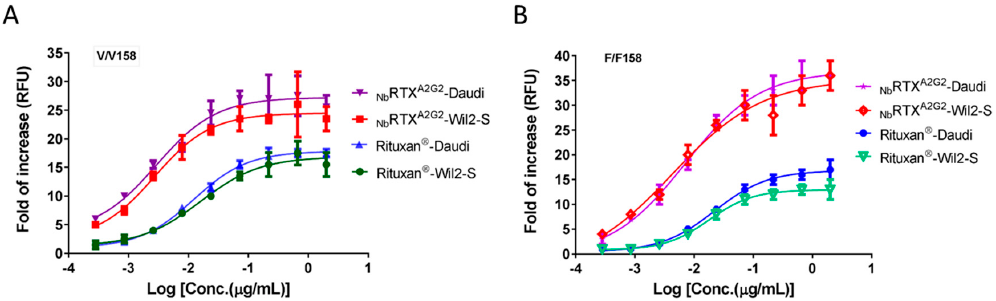
Figure 5. Antibody-dependent-cell-mediated cytotoxicity (ADCC) activity of Rituxan ® and Nb RTX A2G2 with ( A ) V/V 158 Fc γ RIIIa (high affinity) and ( B ) F/F 158 Fc γ RIIIa (low affinity) variant effector cells (engineered Jurkat cells with Fc γ RIIIa receptor). All experiments were carried out using human B lymphoma WIL2-S cells and Daudi cells as target cells. The effector cell: target cell ratio was 10:1. Data are expressed as fold of ADCC increase. Values represent mean ± S.D. for triplicate analyses.